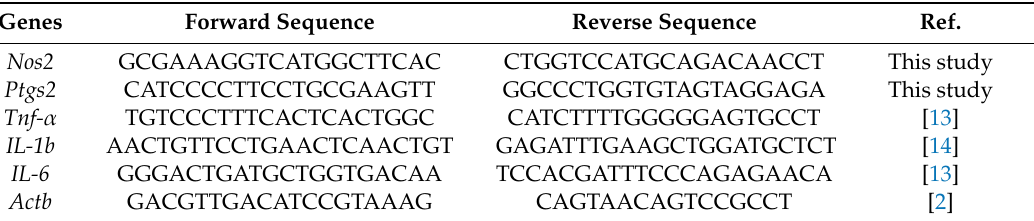
Table 1. The primer sequences (5 (cid:48) –3 (cid:48) ) used in the